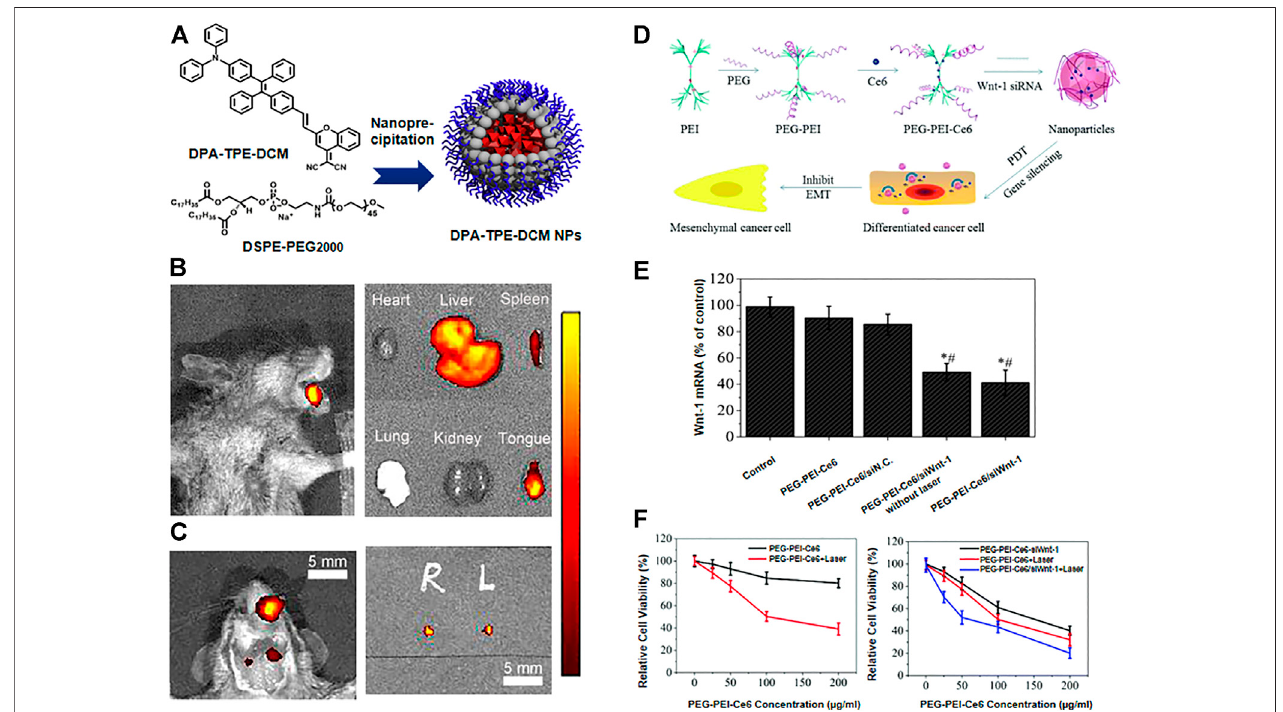
FIGURE 2 | (A) Schematic illustration of the preparation of DPA-TPE-DCM NPs. (B) Fluorescence imaging of tongue squamous cell carcinoma-bearing mice and exvivo fl uorescenceimagesofmajororgansandtongueafterintravenousadministrationofDPA-TPE-DCMNPs. (C) Fluorescenceimagingofthemiceneckandsentinel lymph nodes helped extract from the mice under the guidance of fl uorescence. [ (A – C) Reproduced from (Zhang et al., 2022) with permission from the Royal Society of Chemistry]. (D) Schematicillustration ofPEG-PEI-Ce6/siRNA nanoparticlesand themechanismoftheeffectstheyexert. (E) Theexpression levelsofWnt-1mRNA determined by RT qPCR. (F) In vitro cellular phototoxicity of PEG-PEI-Ce6/siWnt-1 against oral cancer cells. [ (D – F) Reproduced from (Ma et al., 2017) with permission from the Royal Society of